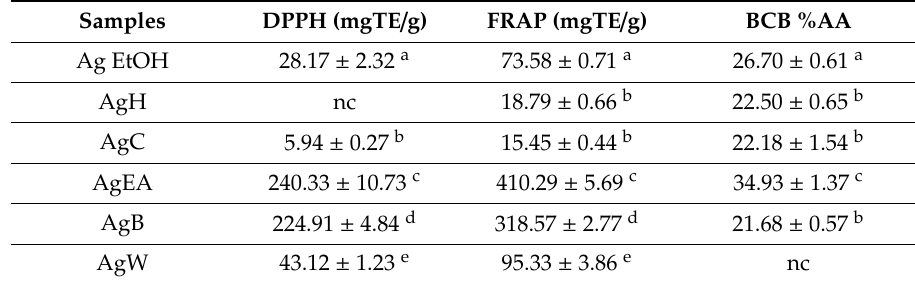
Table 2. Results of DPPH scavenging activity, Ferric Reducing Antioxidant Power (FRAP), and β -Carotene Bleaching assay (BCB) of A. glabra